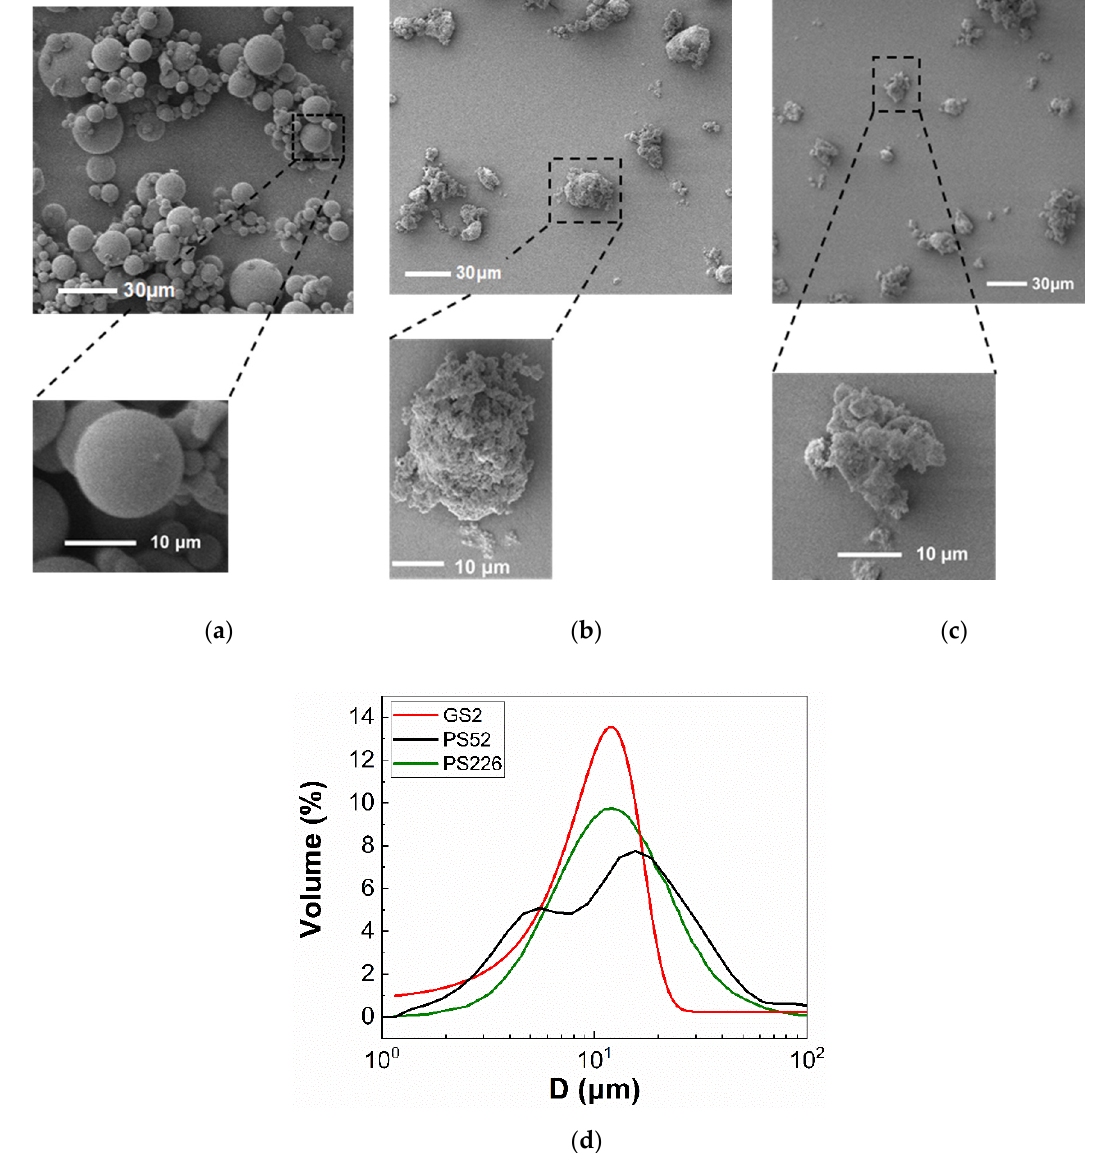
Figure 1. SEM micrographs of the three types of particles used in the present study. ( a ) Glass spheres (GS2); ( b ) Silica particles PS52; ( c ) Silica particles PS226. ( d ) Size distribution of the particles as derived from laser diffraction measurement. Table 1. Particle and solvent characteristics.